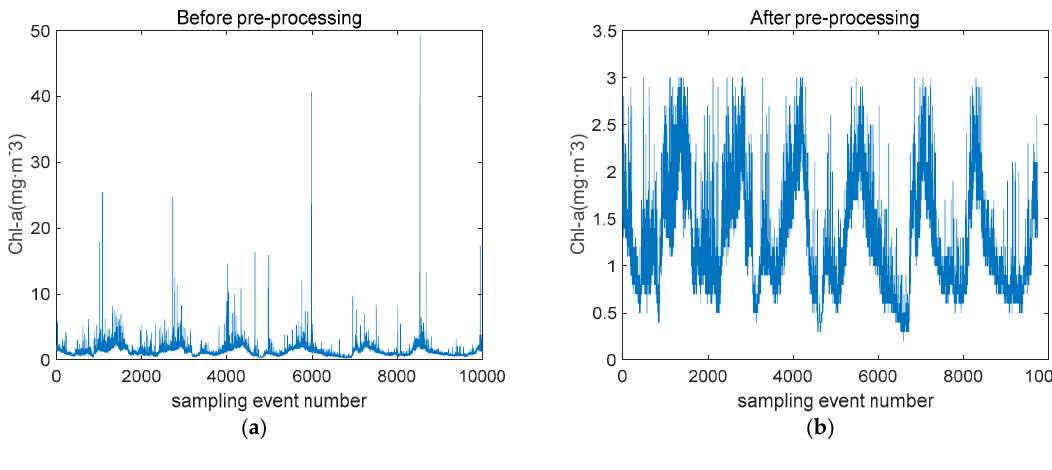
Figure 1. Data pre-processing results.